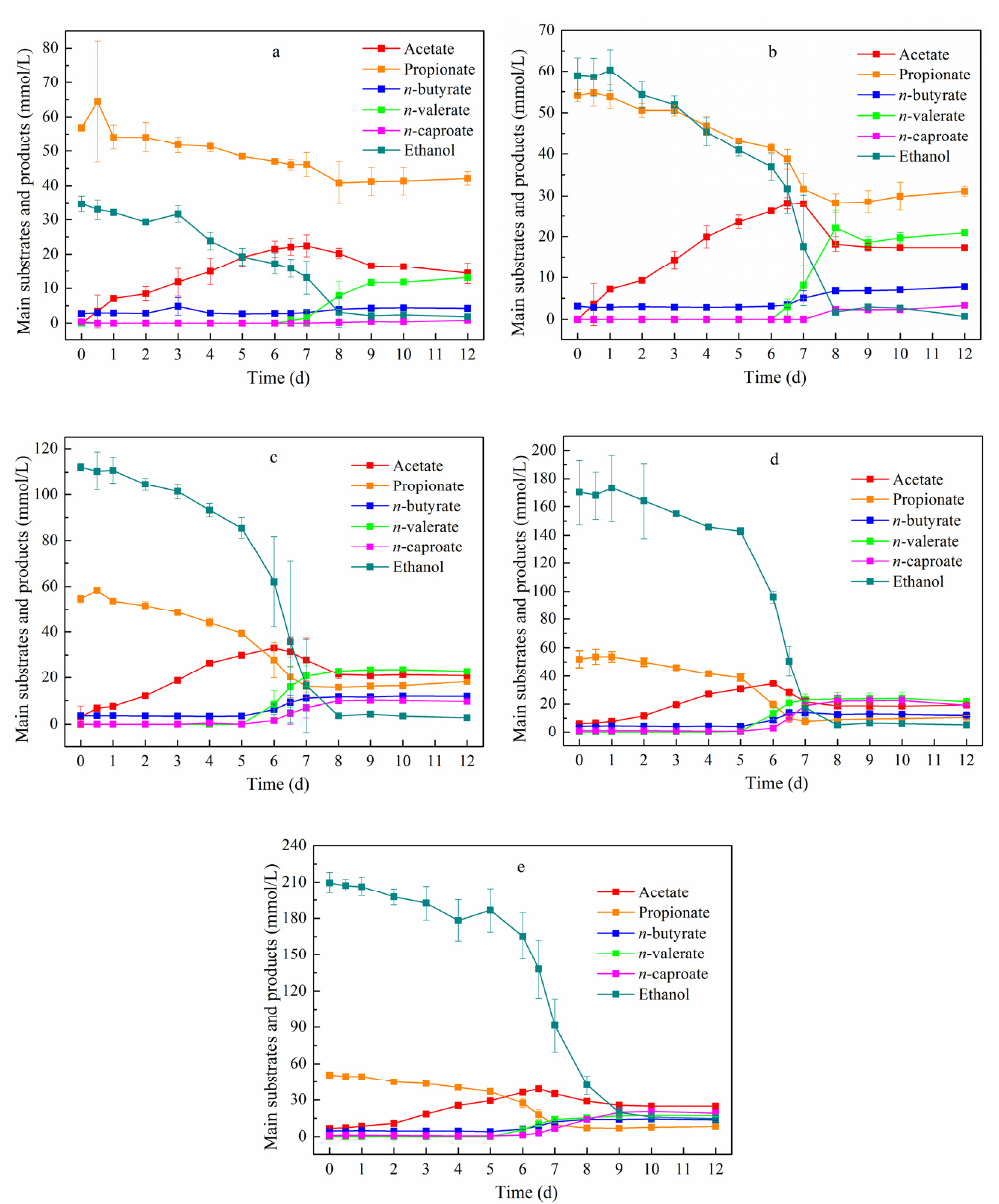
Figure 3. Concentration variation of main substrates and products along chain elongation with propionate/ethanol ratios of 2:1 ( a ), 1:1 ( b ), 1:2 ( c ), 1:3 ( d ), and 1:4 ( e